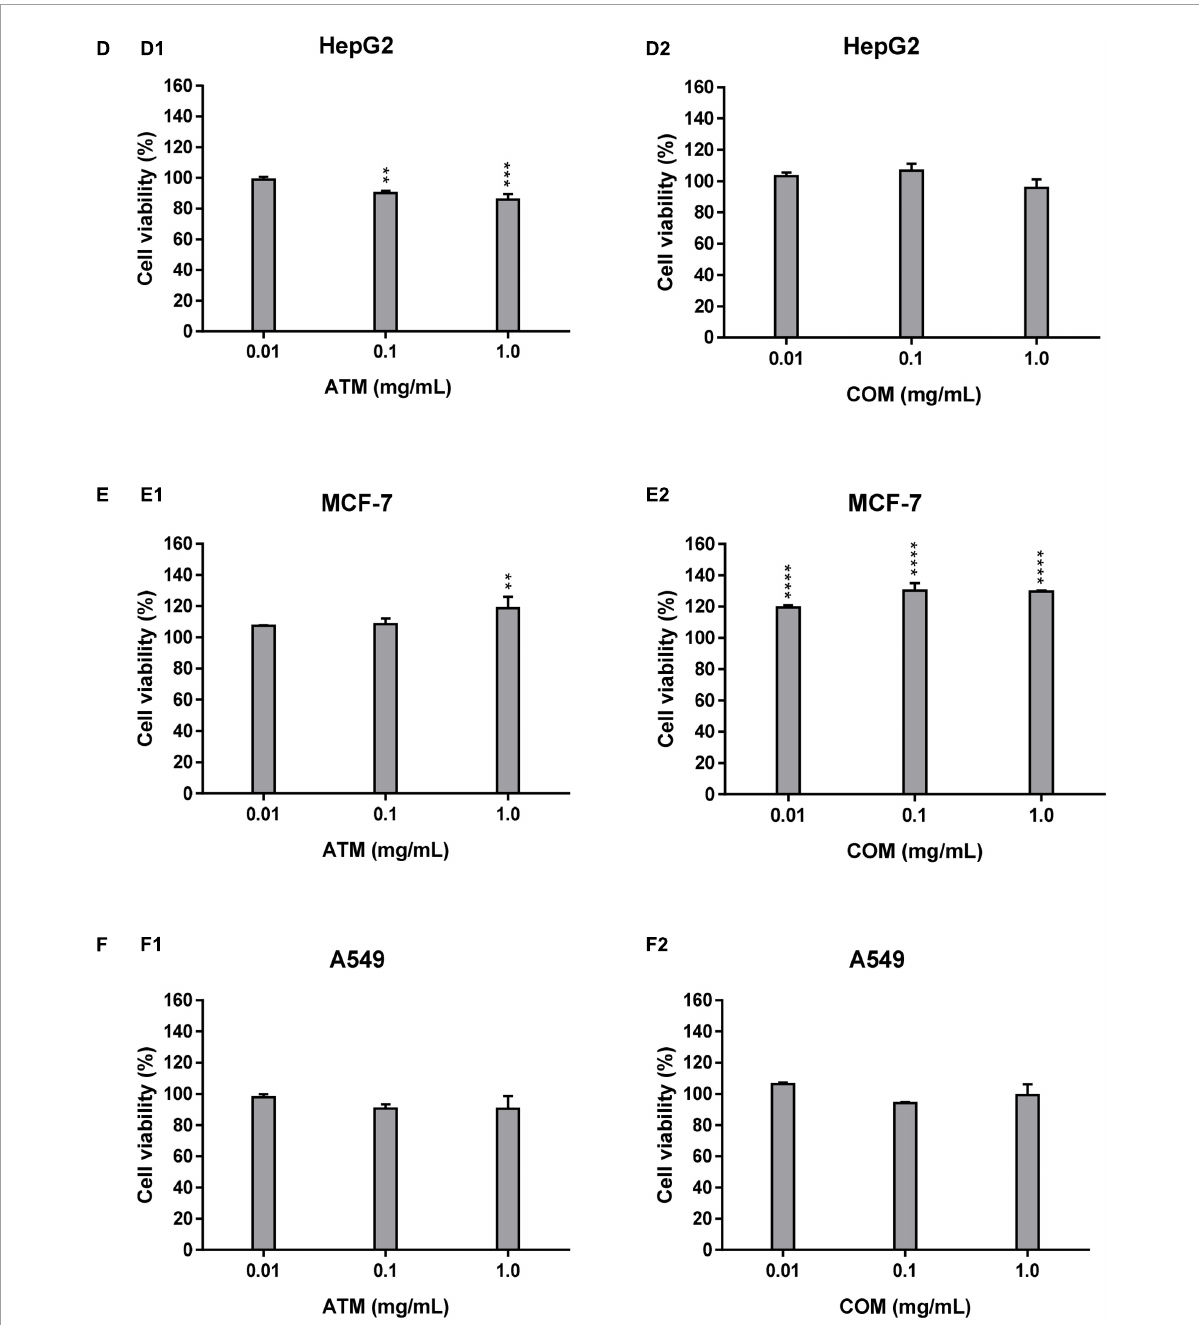
FIGURE1 Cytotoxicity activity of ATM (1) and COM (2) in 3T3 (A) and HaCaT (B) , HeLa (C) , HepG2 (D) , MCF-7 (E) , and A549 (F) cell lines by MTT assay and expressed as a percentage of cell viability respect to control cells Results are expressed as mean ± standard error of n = 3. Control cells were maintained only with a culture medium. A two-way analysis of variance (ANOVA) and a Bonferroni post hoc assay have been performed. Statistical differences were considered as follows: * p ≤ 0.05, ** p ≤ 0.01, *** p ≤ 0.001, and **** p ≤ 0.0001 comparison with no treated cells (negative